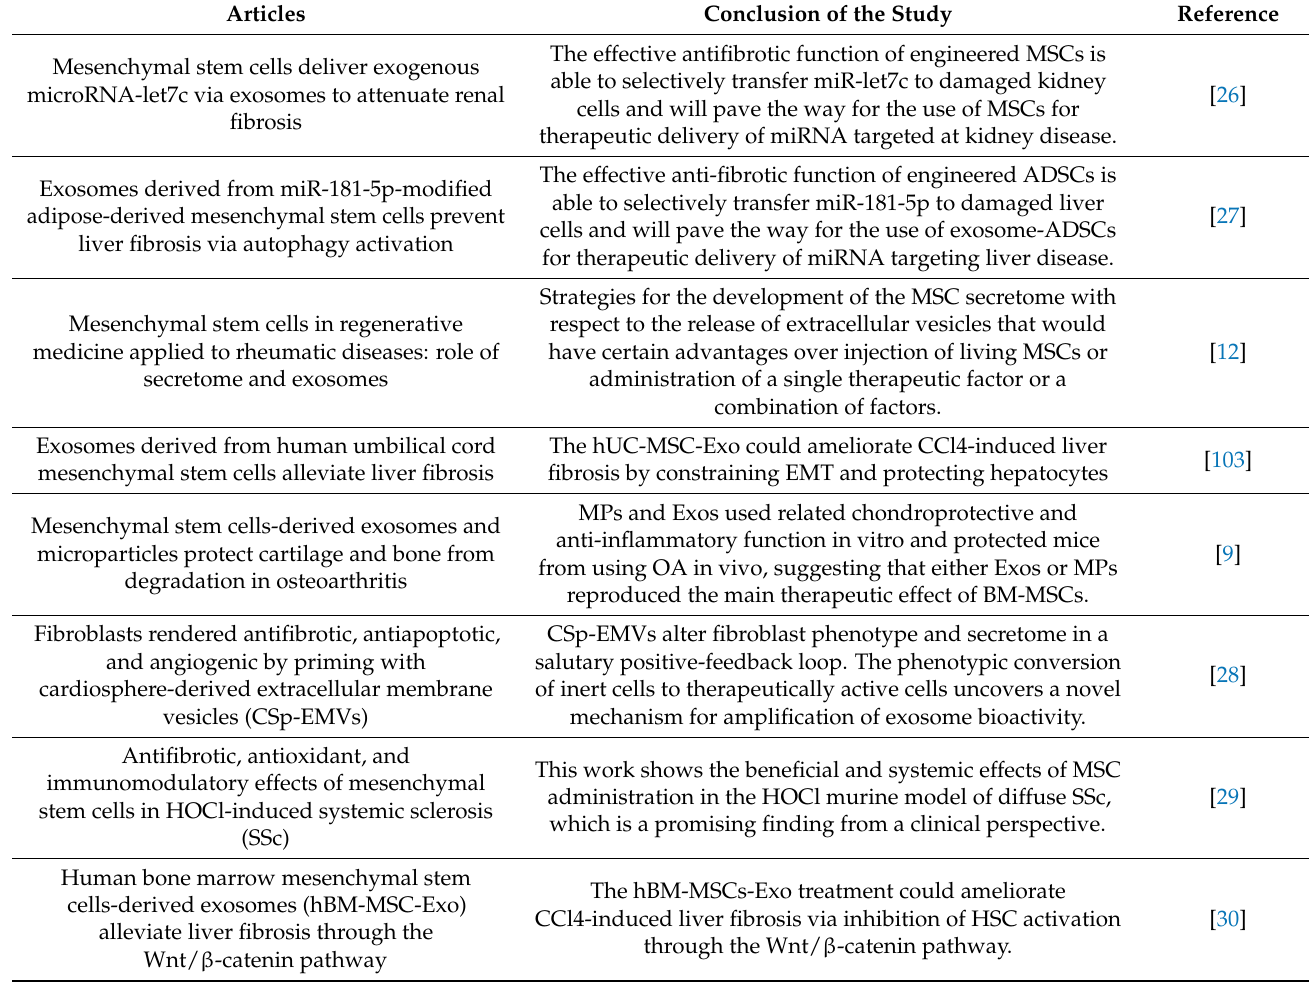
Table 5. Studies showing anti-fibrotic role of mesenchymal stem cells-derived exosomes. Articles Conclusion of the Study